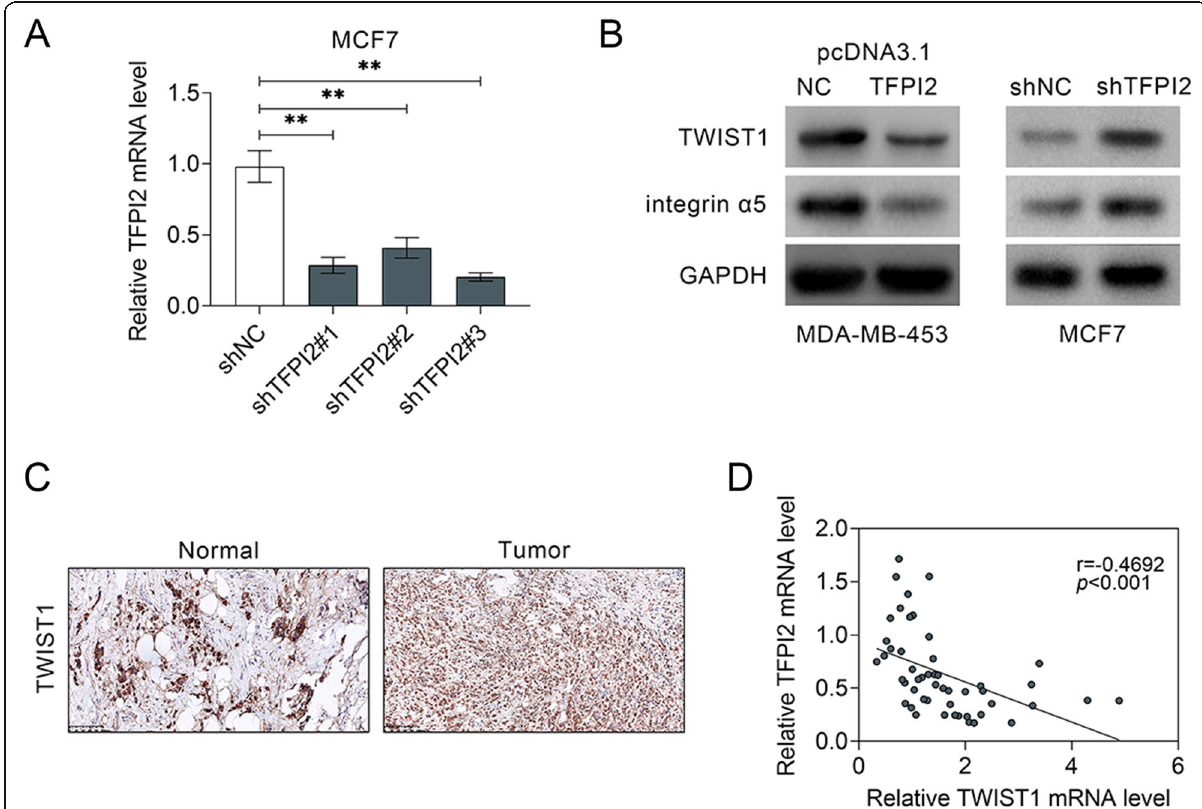
Fig. 4 TFPI2 regulated TWIST1 expression in breast cancer. a Down-regulation of TFPI2 in MCF7 cells transfected with shTFPI2#1. #2, #3 indicated by qRT-PCR. ** represents shTFPI2#1. #2, #3 vs. shNC, p < 0.01. b Over-expression of TFPI2 inhibited protein expression of TWIST1 and integrin α 5, while inhibition of TFPI2 promoted TWIST1 and integrin α 5. c Immunohistochemistry of TWIST1 in Normal and Tumor breast cancer tissues, suggesting up-regulation of TWIST1 in tumor tissues. d Negative correlation TFPI2 and TWIST1 in breast cancer